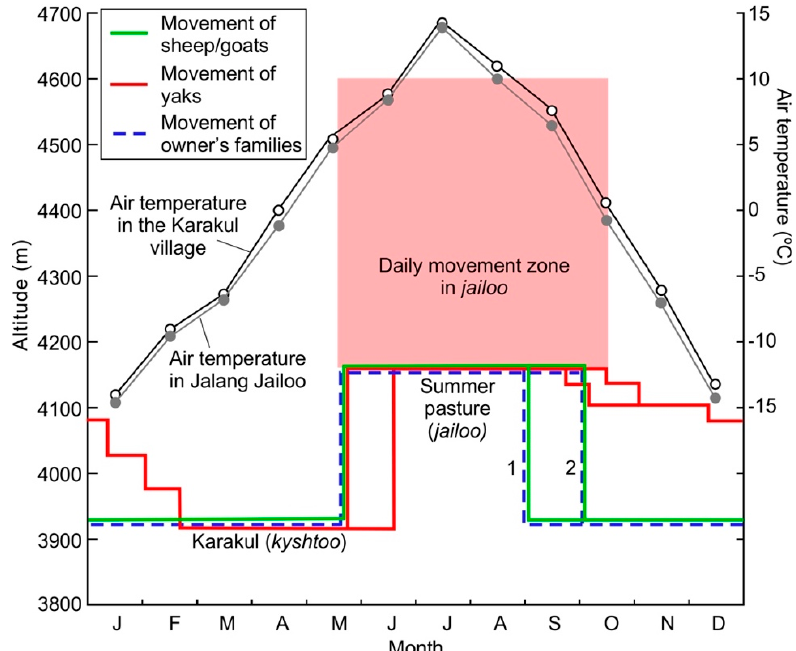
Figure 6. The monthly mean air temperatures in the Karakul village and Jalang Jailoo (Ko6), and the mobility of livestock and pastoral farmers who migrate between the Karakul village and Jalang Jailoo. Depending on the locations of the jailoo , the altitudes where the livestock move every day greatly vary. In the case of Jalang Jailoo, they vary from 4094 m to about 4600 m. The sheep/goats staying in Jalang Jailoo in summer do not stay in bäärlöö in springtime, meaning that they go directly from the village to the jailoo in one day. They stay in küzdöö for only one night in autumn when they go down to the village. Yaks move from the village to the jailoo by taking a few days, but from the jailoo to the village taking 4–5 months using küzdöö in autumn/early winter time.